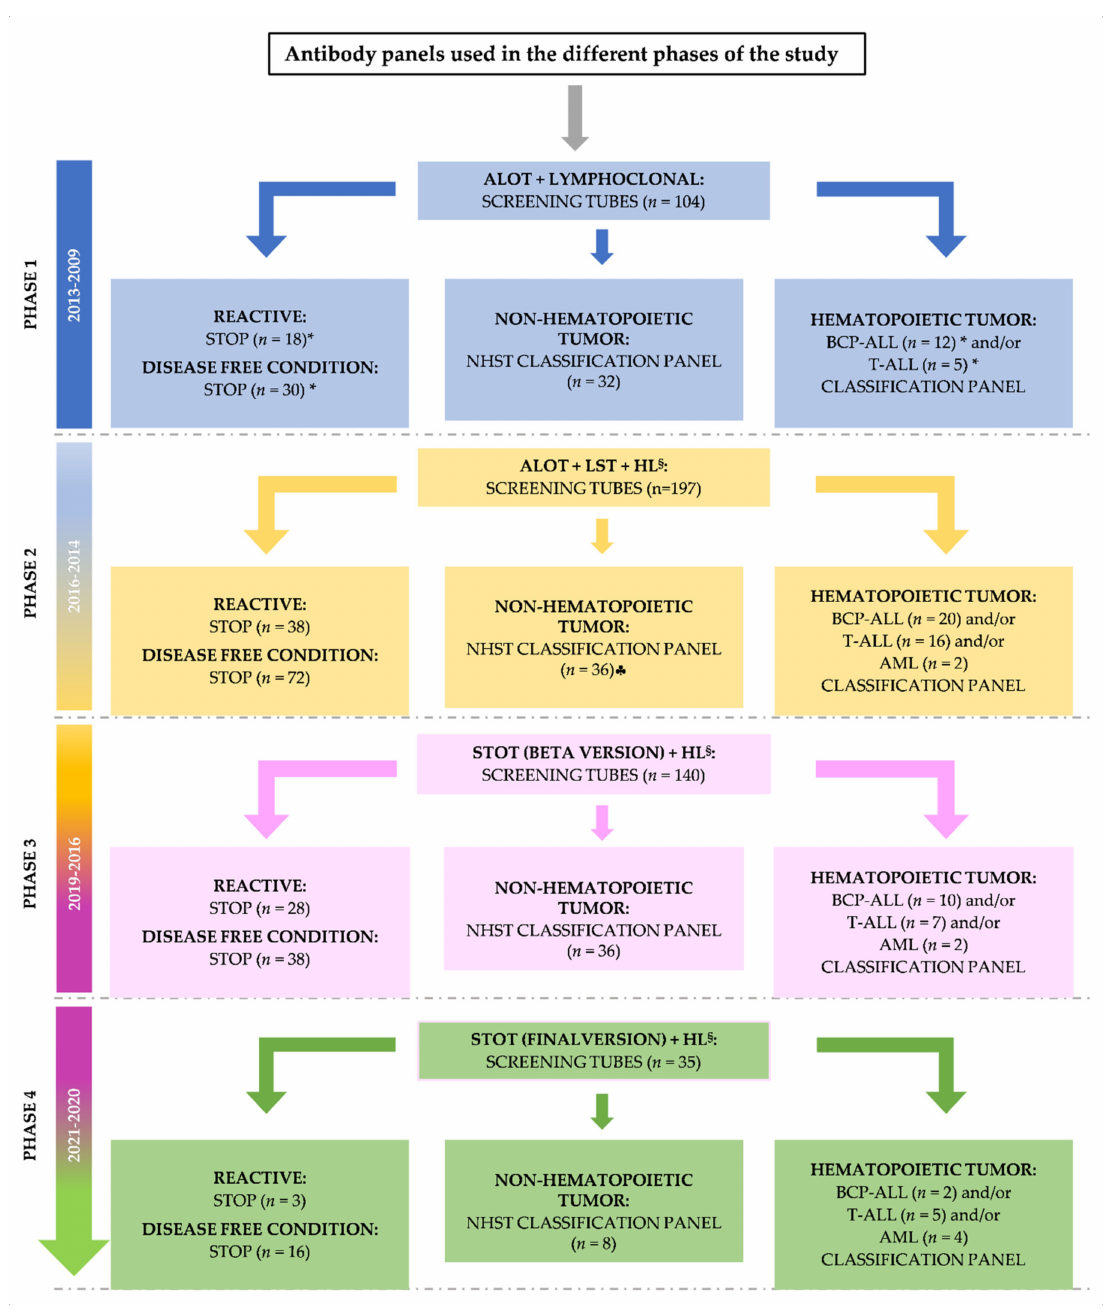
Figure 1. Flowchart of the distinct phases of the study and the corresponding antibody panels evaluated for the diagnostic screening, orientation, and classification of pediatric tumors. * Among these samples, 4 reactive samples, 11 disease-free samples, and 7 hematopoietic malignant samples were also tested with the non-hematopoietic solid tumor (NHST) panel. ♣ In addition to these samples, 6 samples the NHST complete panel could not be stained because of very limited cellularity. § The Hodgkin lymphoma (HL) tube was stained in 72 samples across the 3 phases in which it was tested, including specimens from 7 ALCL, 15 HL, 7 hematopoietic tumors, 10 non-hematopoietic tumors, and 33 reactive/disease free lymph node samples. Abbreviations: ALOT—acute leukemia orientation tube; AML—acute myeloid leukemia; BCP-ALL—B-cell precursor–acute lymphoblastic leukemia; LST—lymphoid screening tube; T-ALL—T-cell acute lymphoblastic leukemia; STOP–end of